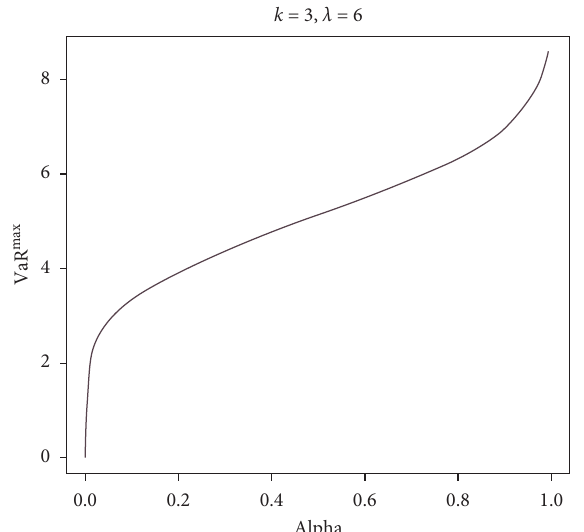
� 20, θ � 5, θ � 8, θ � 7 , 5 for all l ∈ 1 , ... , s { } and li l l 1 l 2